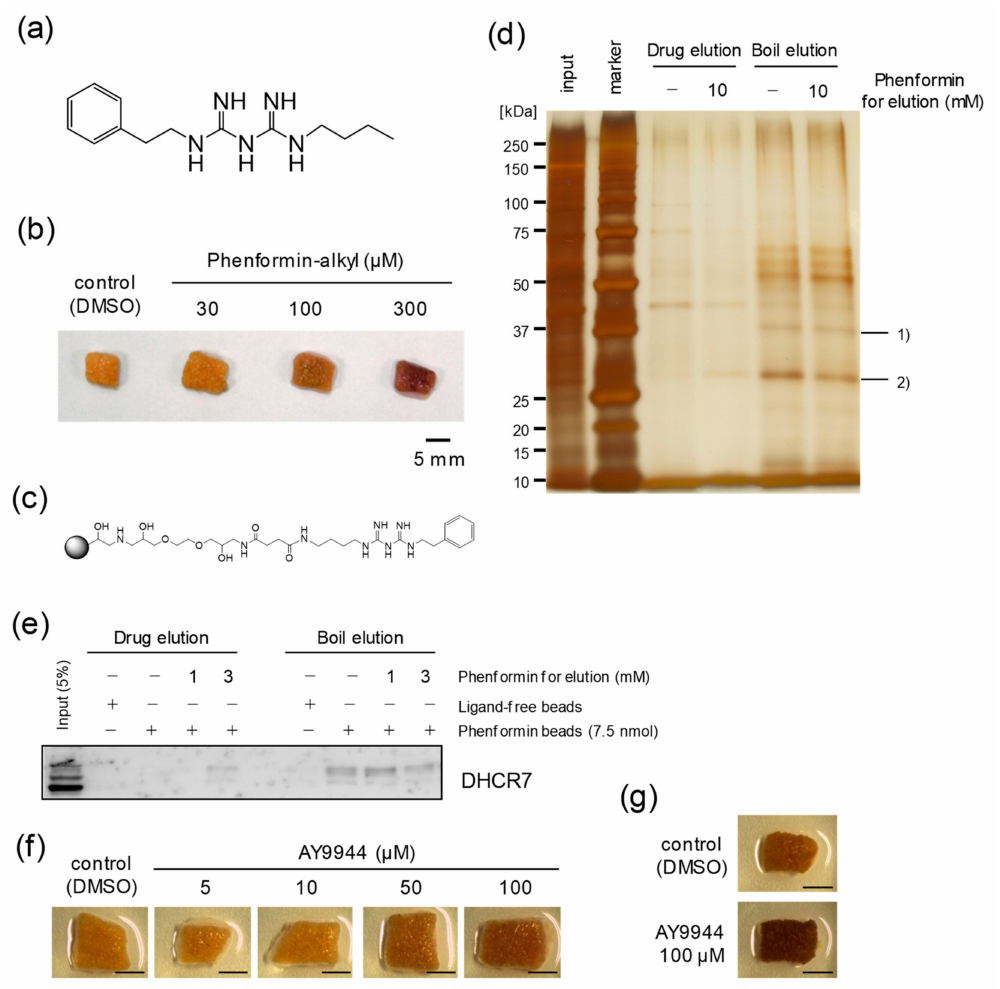
Figure 3. Identification of phenformin-binding proteins. ( a ) Chemical structure of phenformin-alkyl form. ( b ) Skin tissues obtained from a Japanese subject (age unknown) were treated with or without phenformin-alkyl form for 7 days (at the indicated concentrations). The photographs shown are representative samples. Scale bar = 5 mm. ( c ) Chemical structure of phenformin-immobilized FG-beads (phenformin-beads). ( d ) Lysates of NHEKs were incubated with phenformin-beads (7.5 nmol) for 4 h. After unattached beads were washed out, the co-precipitated proteins were eluted as described in the “Materials and Methods”. The co-precipitated proteins, bands marked 1) and 2), with phenformin-beads were identified by LC-MS / MS analysis. ( e ) Confirmation of the binding of phenformin to DHCR7 by Western blot analysis using an anti-DHCR7 antibody. ( f ) Skin tissues obtained from a Japanese subject (47y) were incubated with or without AY9944 for 7 days (at the indicated concentrations). The photographs shown are representative samples. Scale bars = 5 mm. ( g ) Skin tissues obtained from another Japanese subject (55y) were cultured with or without 100 µ M AY9944 for 7 days. The photographs shown are representative samples. Scale bars = 5